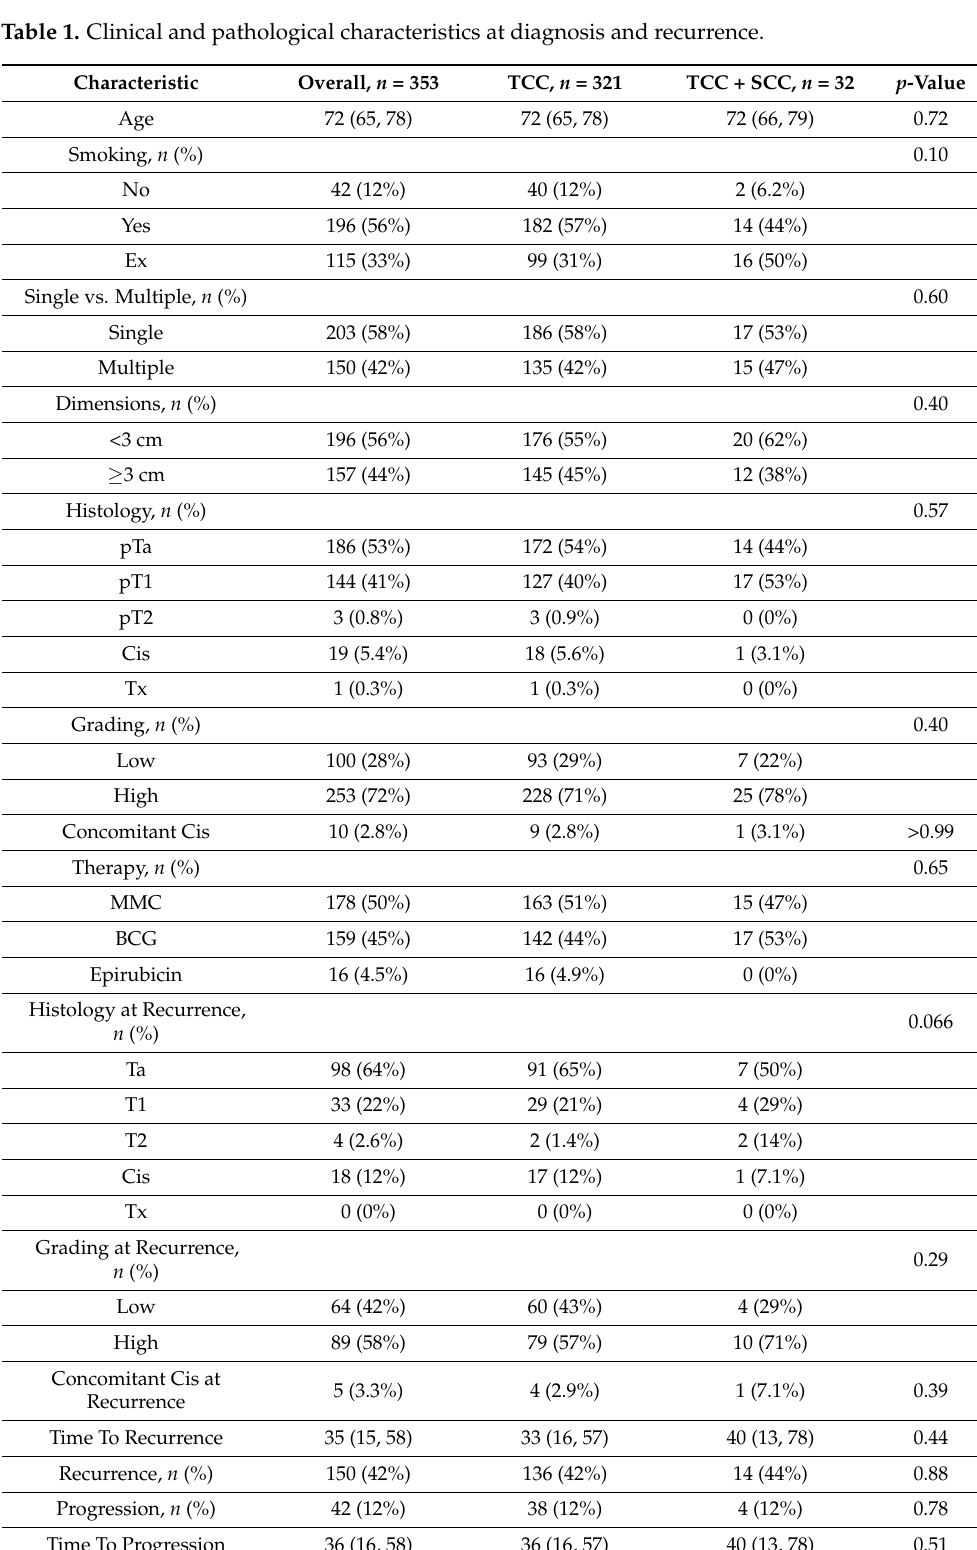
Table 1. Clinical and pathological characteristics at diagnosis and